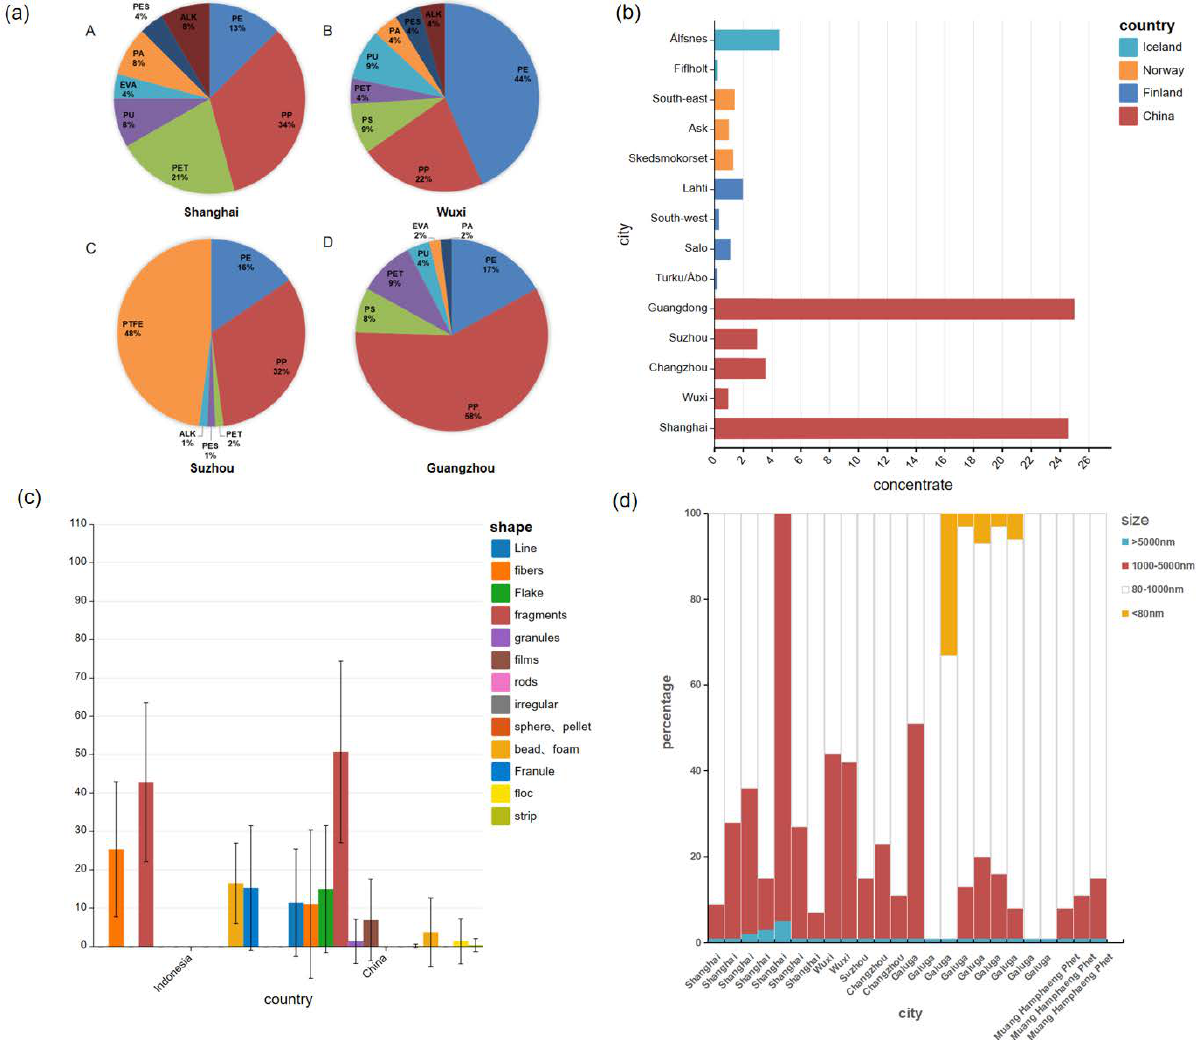
Figure 3. (a) Type and percentage of Microplastics in leachate, Urban, China. A: Shanghai B: Wuxi C: Suzhou D: Changzhou [14,66]; (b) concentrations of microplastics in leachate in different cities in B: Wuxi C: Suzhou D: Changzhou [14,66]; ( b ) concentrations of microplastics in leachate in different different countries [20,38]; (c) microplastic shapes in leachate in different cities in different countries cities in different countries [20,38]; ( c ) microplastic shapes in leachate in different cities in different [38,67]; (d) the percentage of microplastic size in leachate in different cities [14,67]. countries [38,67]; ( d ) the percentage of microplastic size in leachate in different cities